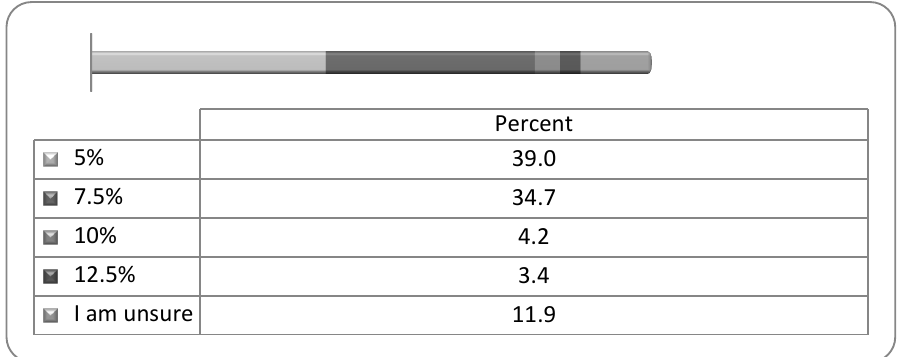
FIGURE 1: Percentage of contribution to the provident fund Source: Authors’